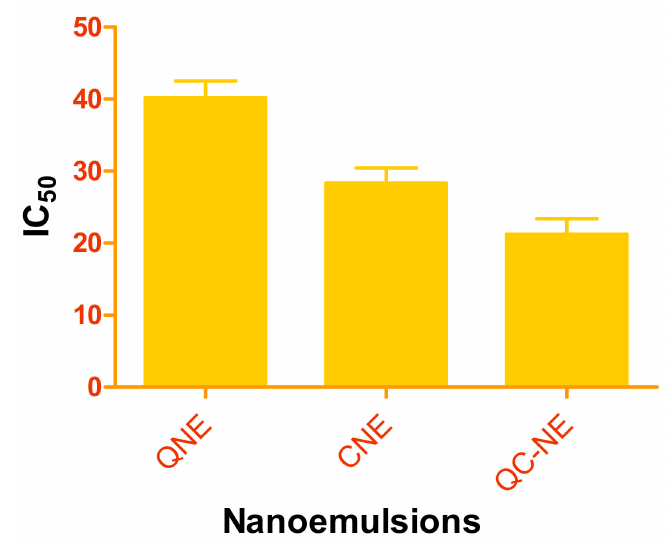
Figure 5. IC 50 value of nanoemulsions (QNE, CNE and QC-NE).